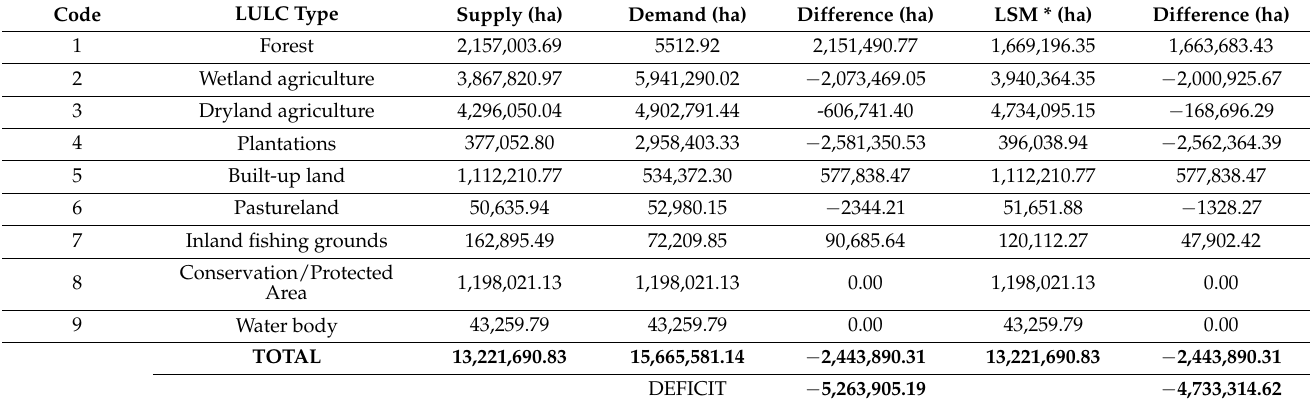
Table 13. The comparison of supply based fulfillment and land suitability based fulfillment in Java